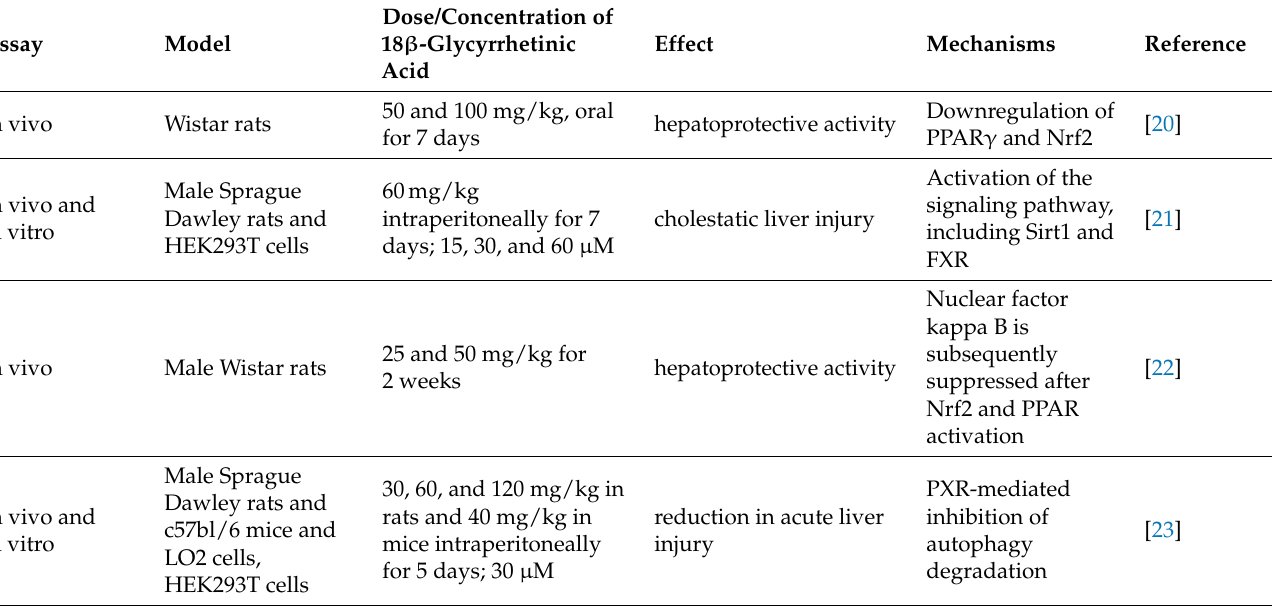
Table 1. Hepatoprotective, anticancer activity, role in arrhythmia, ischemic stroke, and mechanisms of 18 β -glycyrrhetinic acid in both in vitro and in